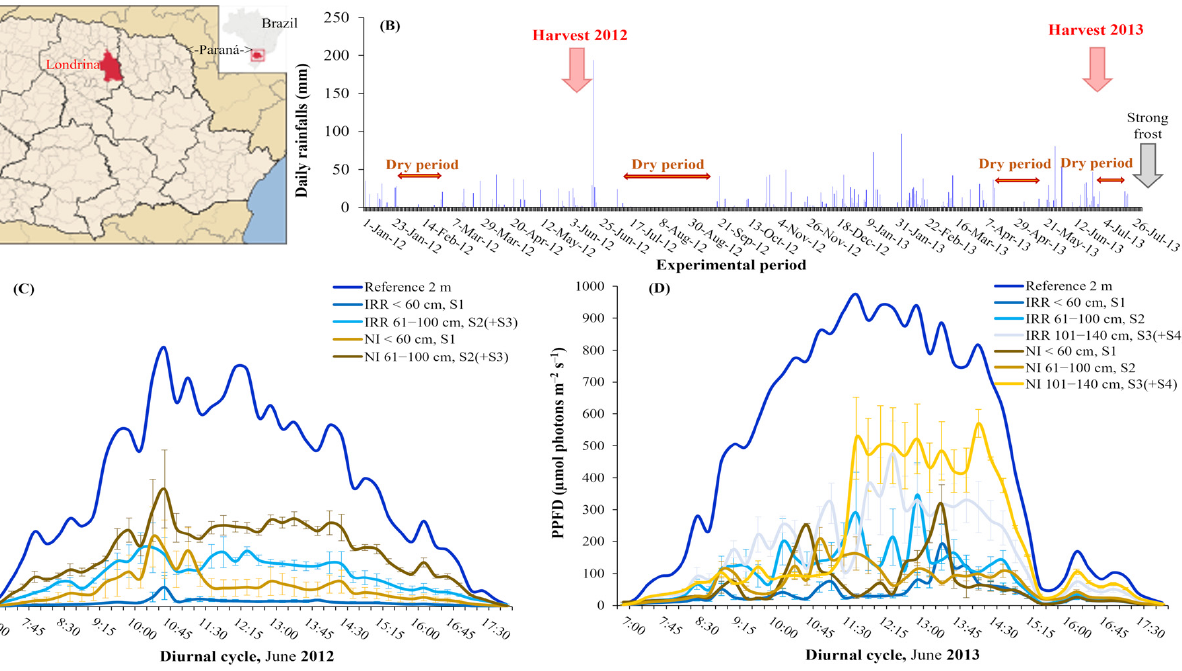
Figure 2. Experimental site localization and the environmental factors during experiment. ( A ) Londrina localization is tagged in red at Northwest of Paraná state, Brazil; ( B ) Daily rainfalls during the experimental period, periods of 2012 and 2013 harvests, dry periods, and the strong frost that ended the experiment are tagged. Photosynthetic photon flux density (PPFD, μ mol photons m − 2 s − 1 ), values (means ± standard errors, n = 4), registered along the plant canopy strata and in the reference (2 m above soil) in ( C ) June 2012, and ( D ) June 2013.